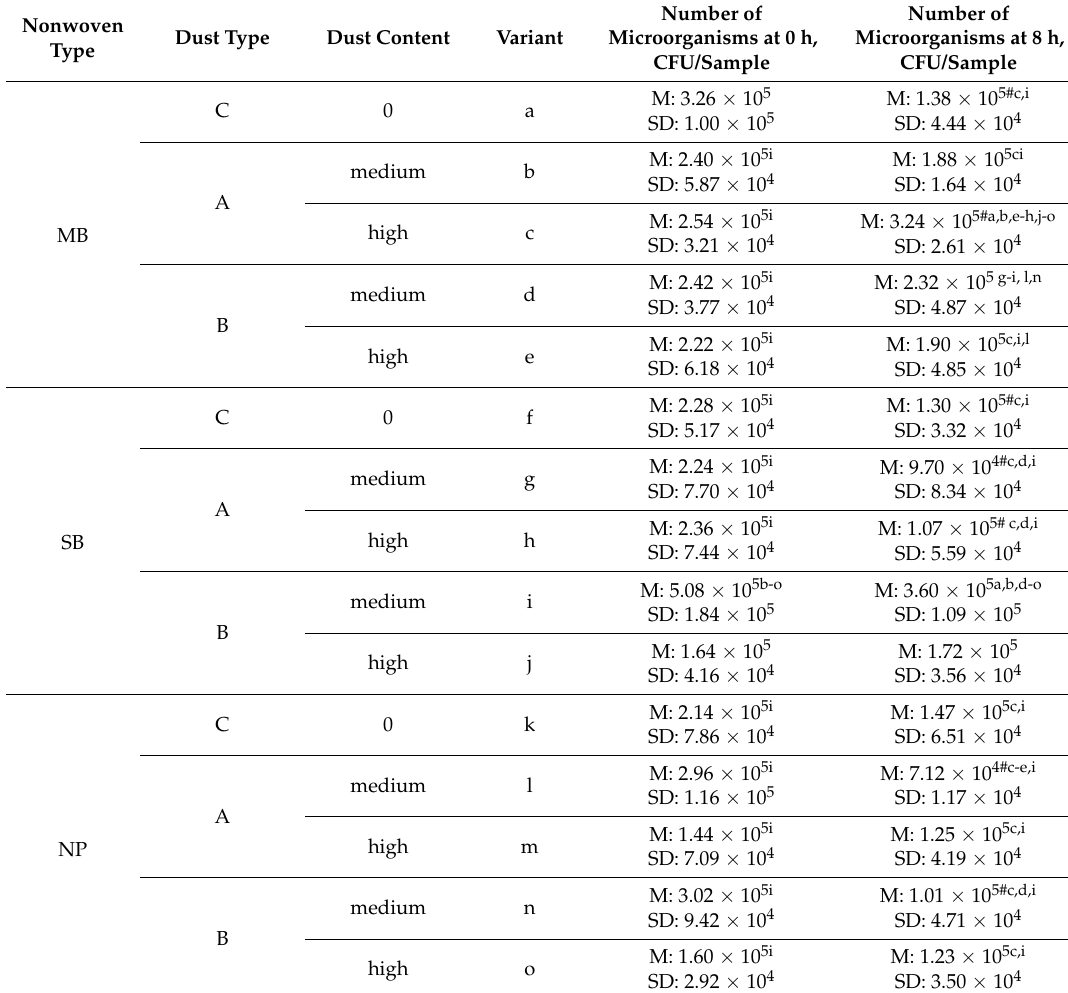
Table 5. Number of Aspergillus niger moulds on the filtering nonwovens depending on dust-type and content. Nonwoven